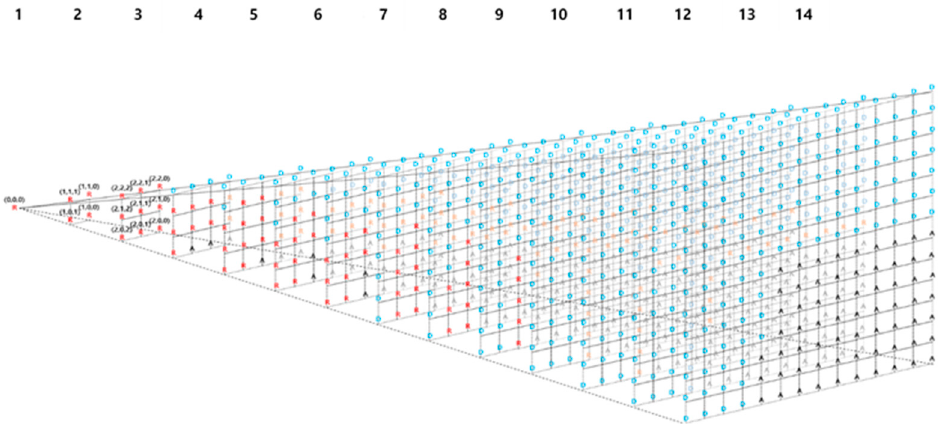
Figure 5. Three-dimensional optimal decision lattice in standard volatility scenario (A: abandonment, D: deployment, R: R&D investment).